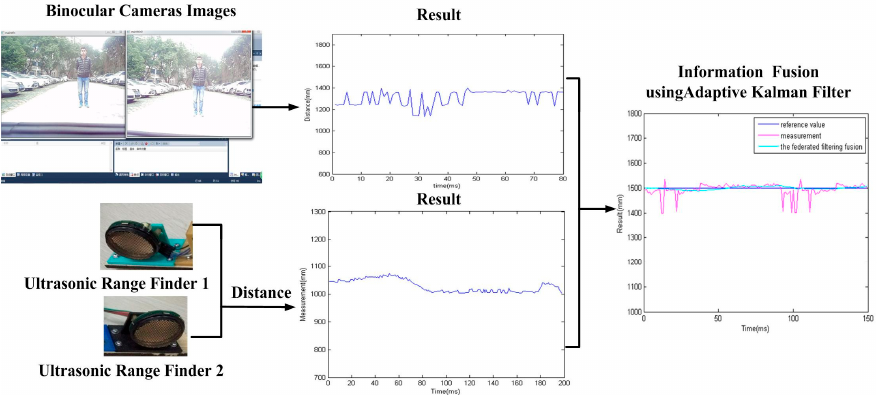
Figure 2. Process of information fusion.